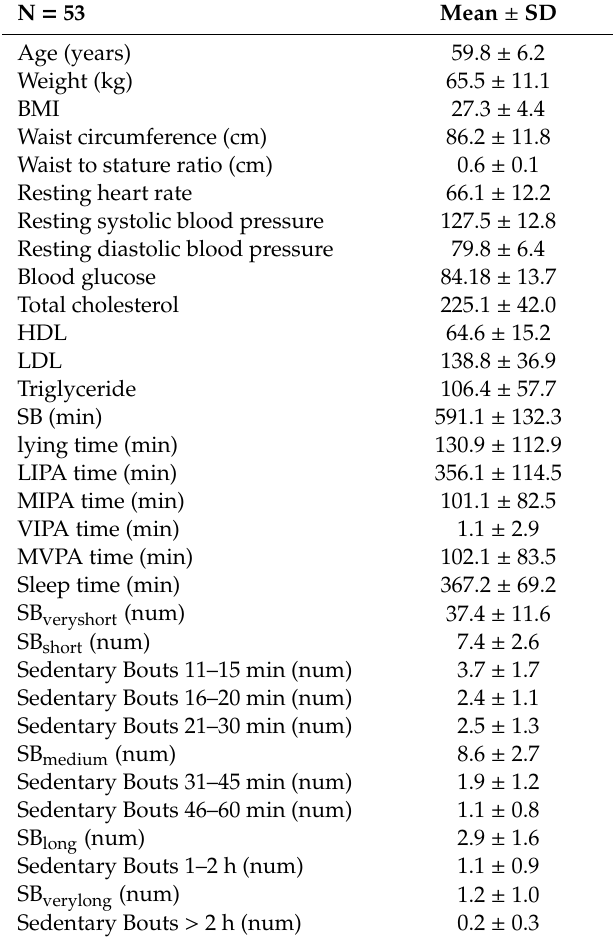
Table 1. Characteristics of the